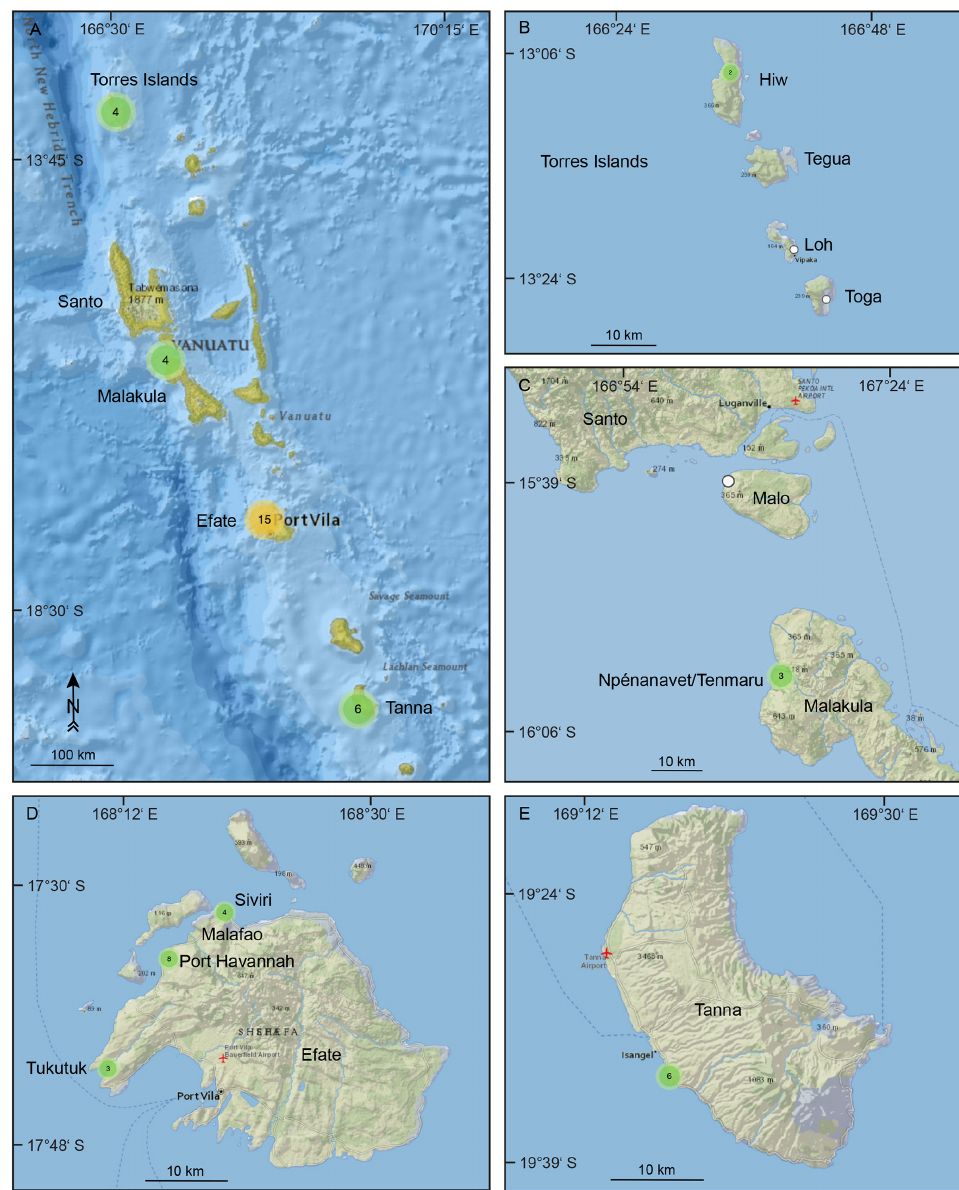
Figure 9. Map showing islands in Vanuatu considered in this article (green and orange circles). Study sites are indicated by white and green circles. Basemap: “National Geographic Map”, with data from National Geographic, Esri, Garmin, HERE, UNEP-WCMC, USGS, NASA, ESA, METI, NRCAN, GEBCO, NOAA and INCREMENT P